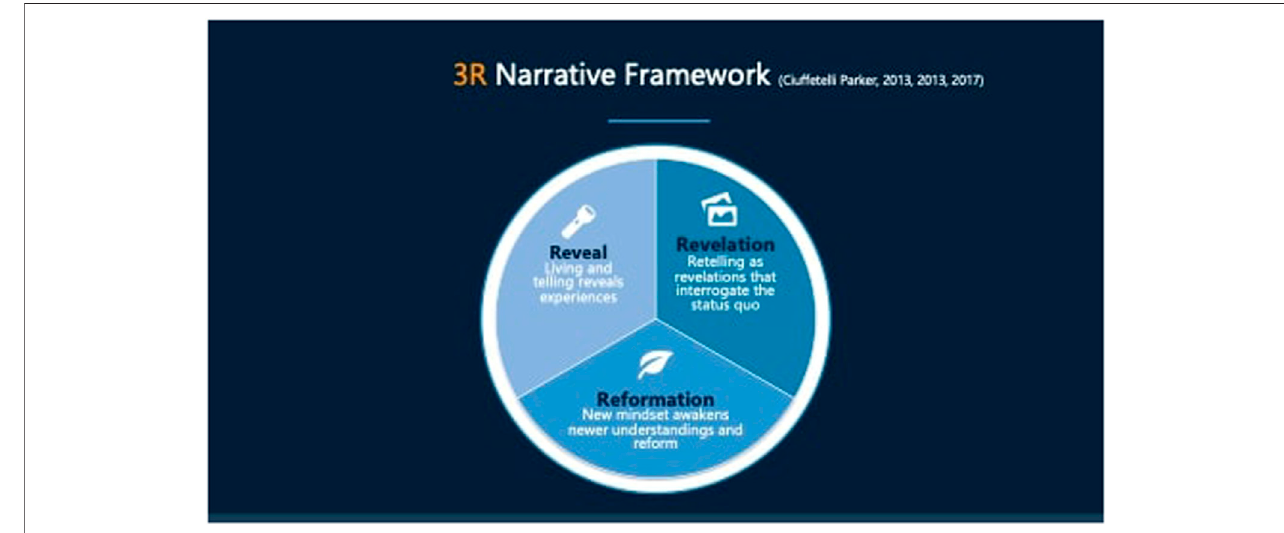
FIGURE 1 | 3R narrative framework (Ciuffetelli